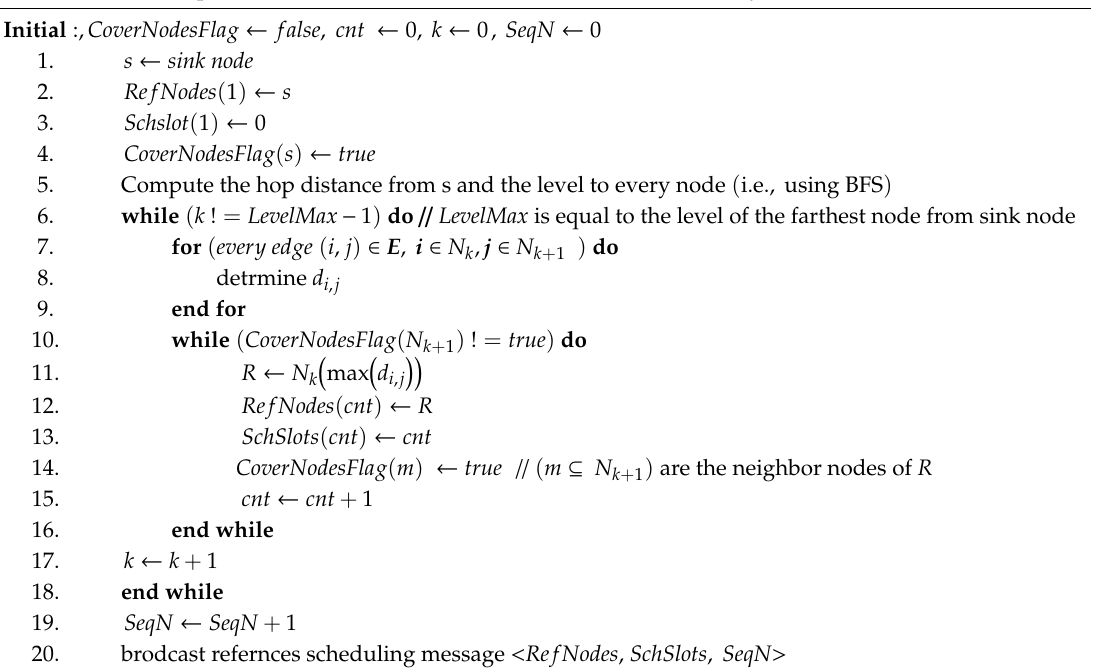
Algorithm 1: EERS pseudo-code for reference node selection (sink node